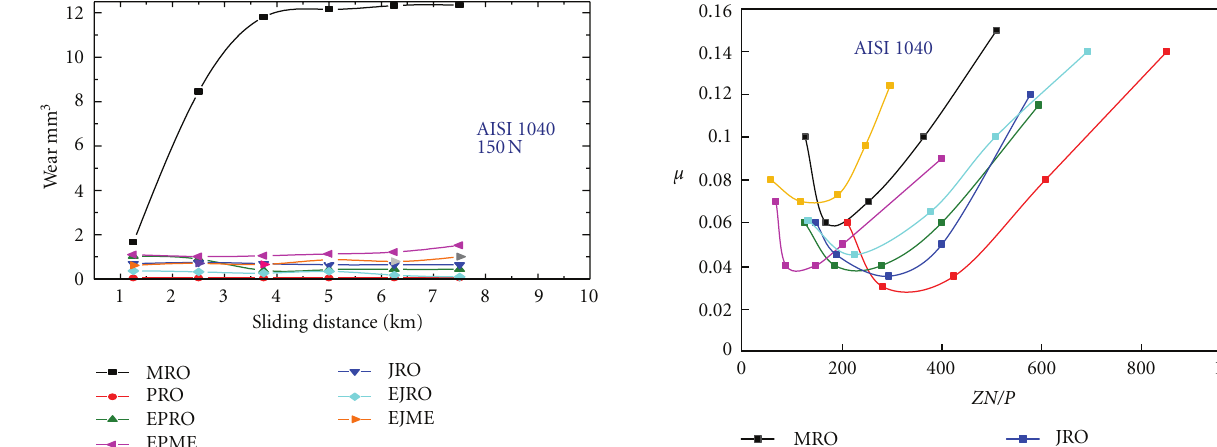
of friction ( µ ) and loads (P), keeping speed (N) and viscosity (Z) constant; Figure 9 represents the Stribeck curves for AISI 1040 under various lubricant